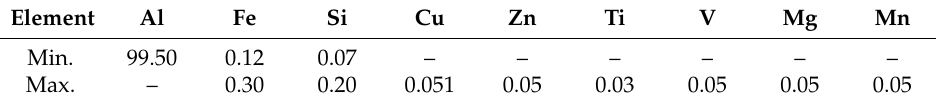
Table 1. Chemical composition of commercial AA 1050 (weight percent)